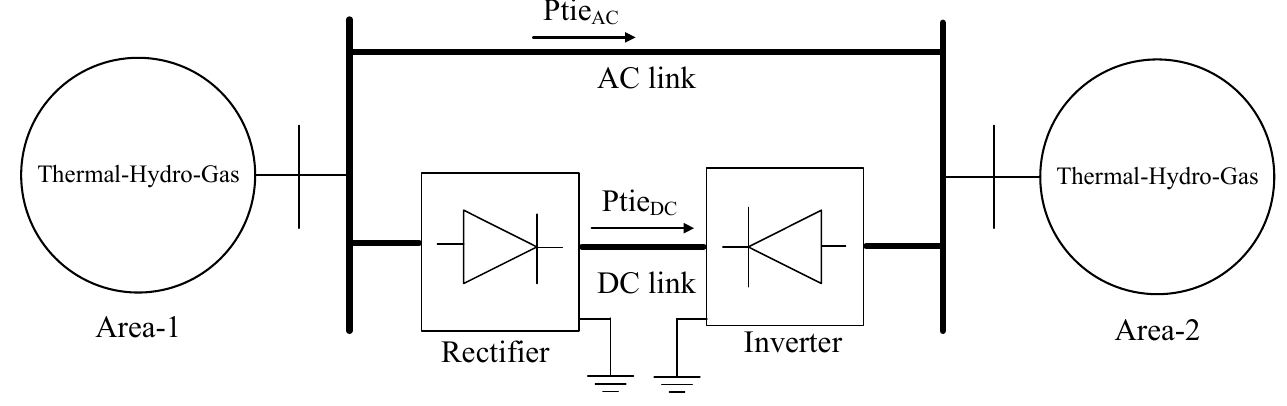
Figure 13. AC-DC parallel links for the considered system.